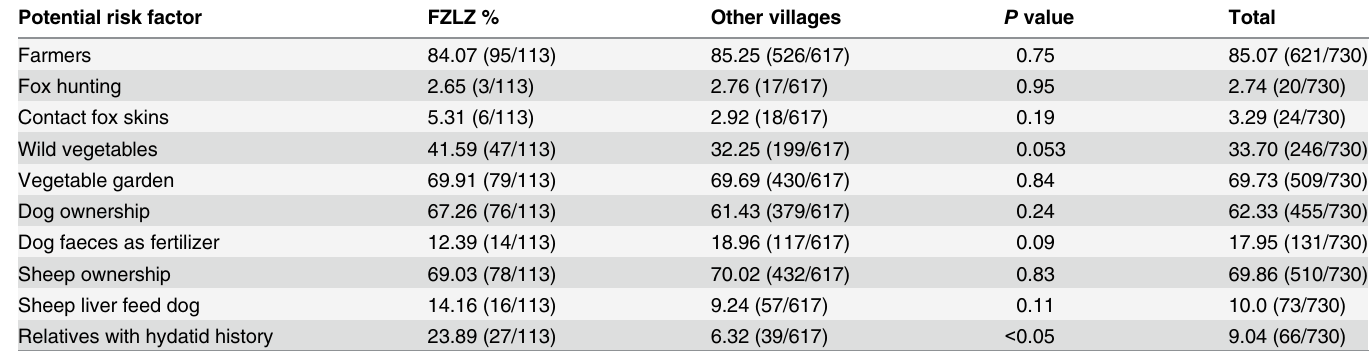
Table 2. Potential risk factors for human hydatids disease in Nanfeng Town. People habits were compared between FZLZ and other villages using Chi- Square-test. Potential risk